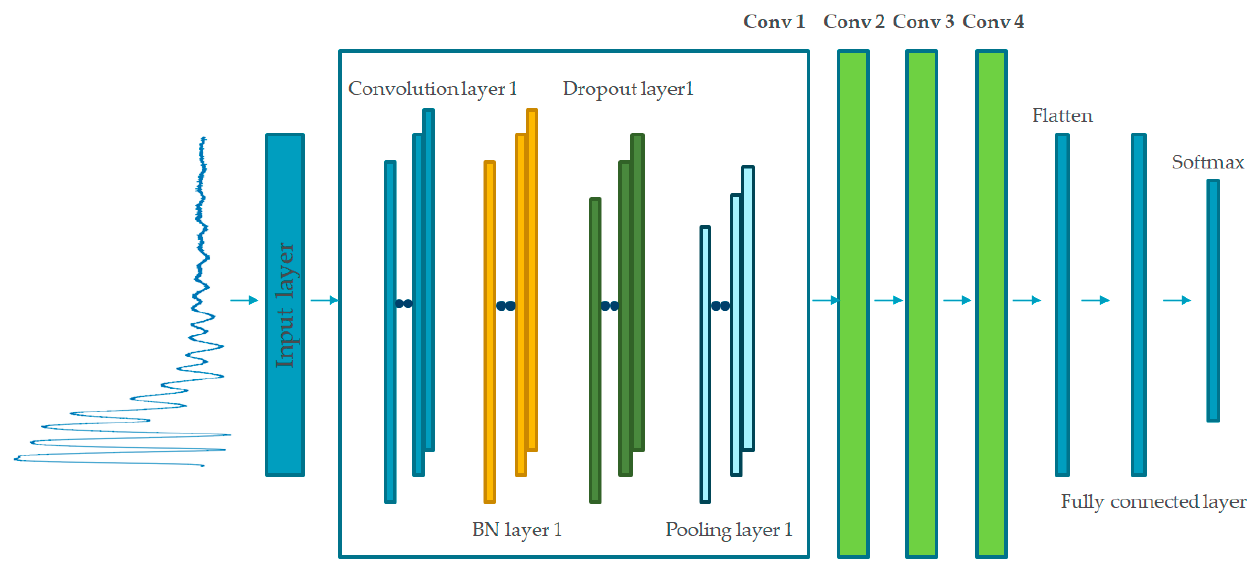
Figure 11. Construction of the proposed 1D CNN model.